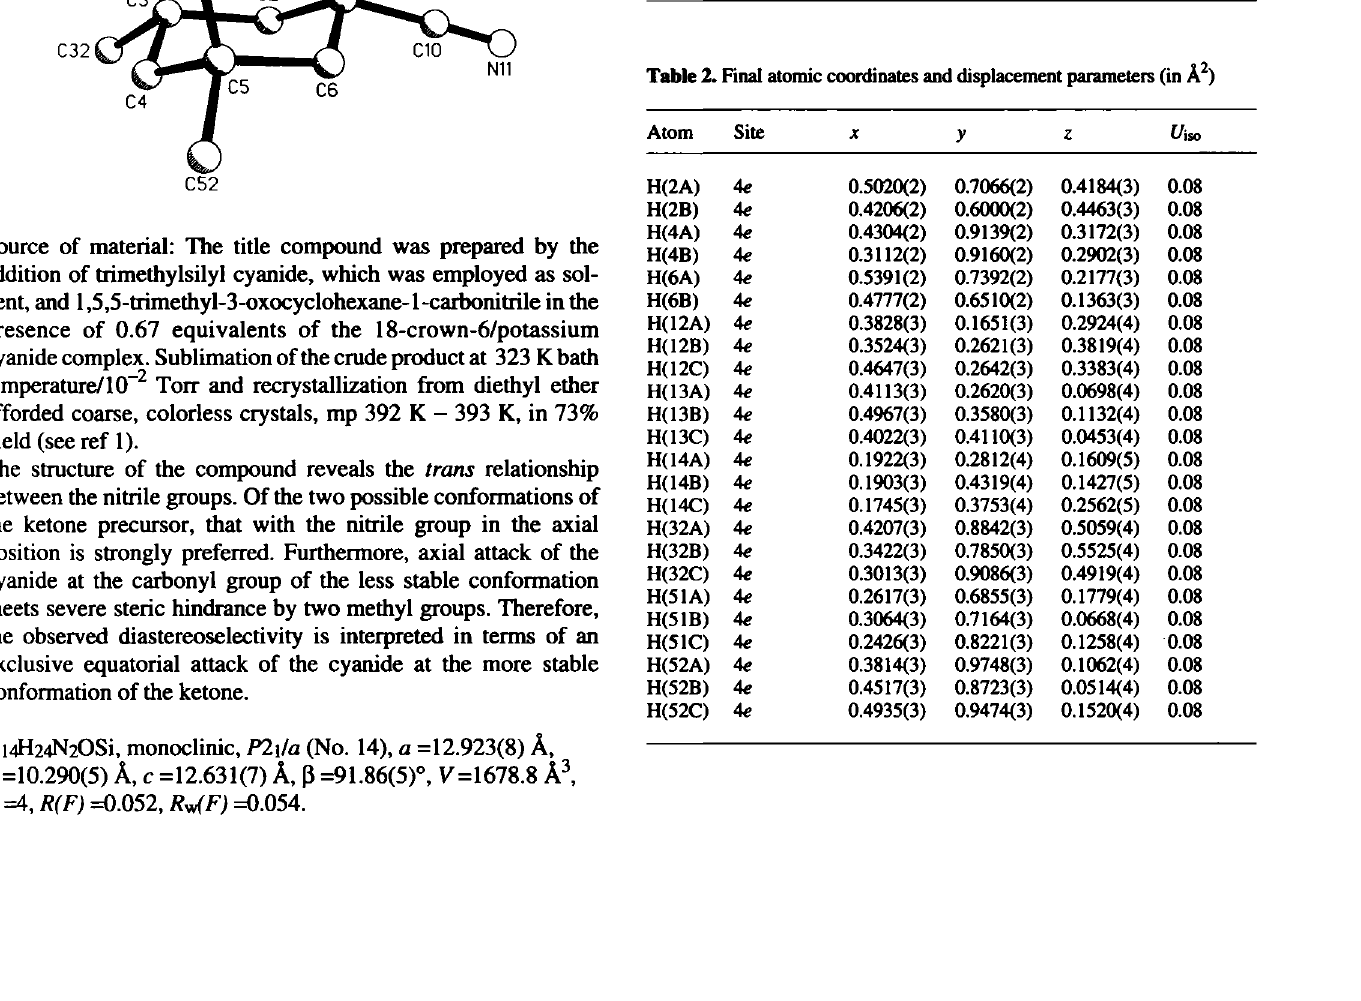
Table 1. Parameters used for the X-ray data collection